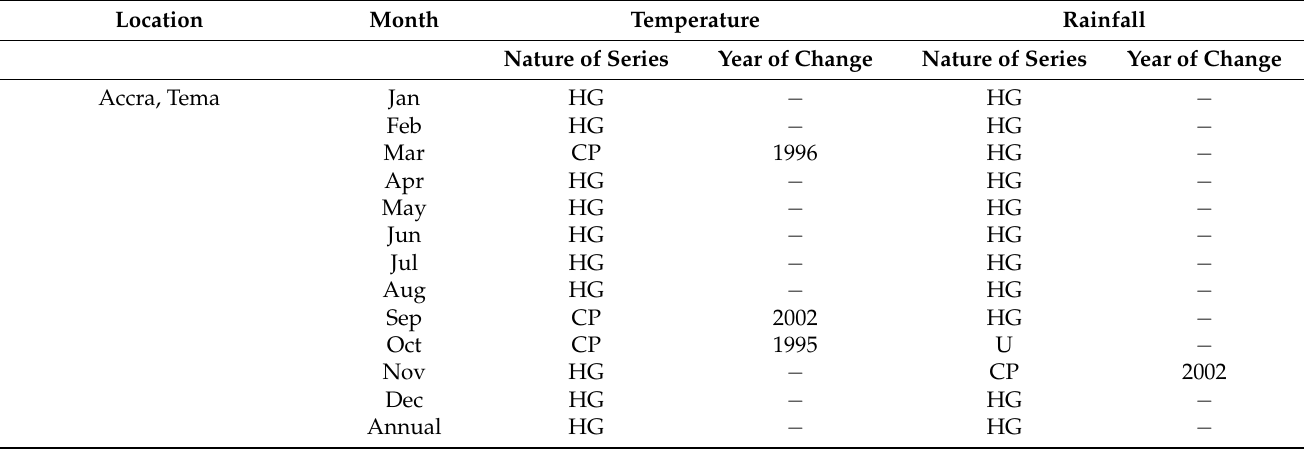
Table 1. Changepoint analysis for temperature and rainfall. Note: * HG Homogeneous, * CP Change point, * U